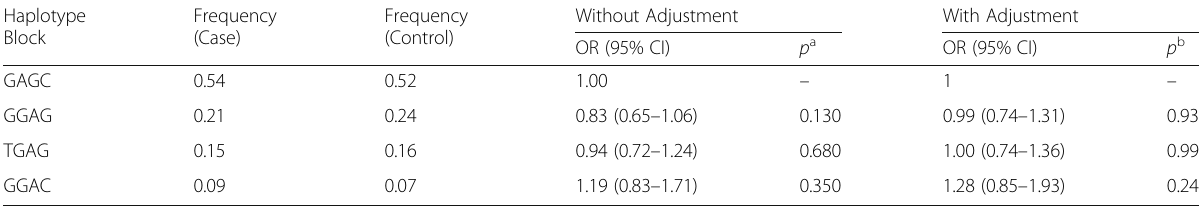
Table 4 Haplotype analysis of the IL-1B block formed by rs1143630, rs1143627, rs16944, and rs1143623, and the association with EC risk